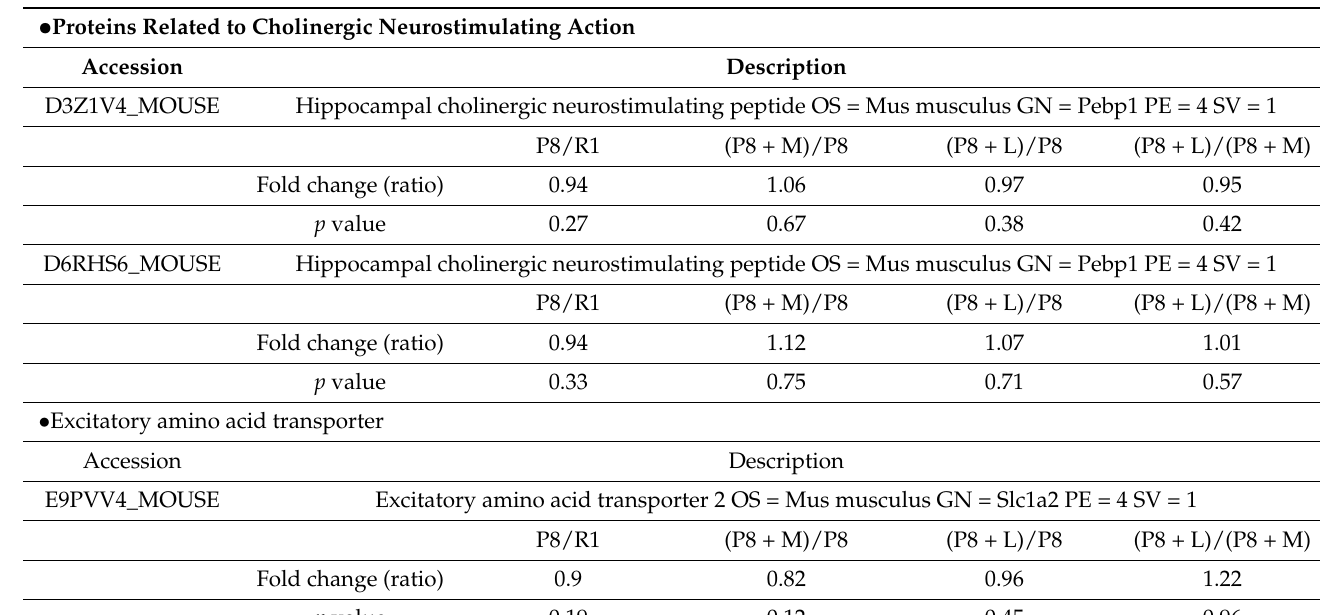
Table 6. Effects of feeding with matcha and decaffeinated matcha on the expression of proteins involved in cholinergic neurostimulating action and on excitatory amino acid